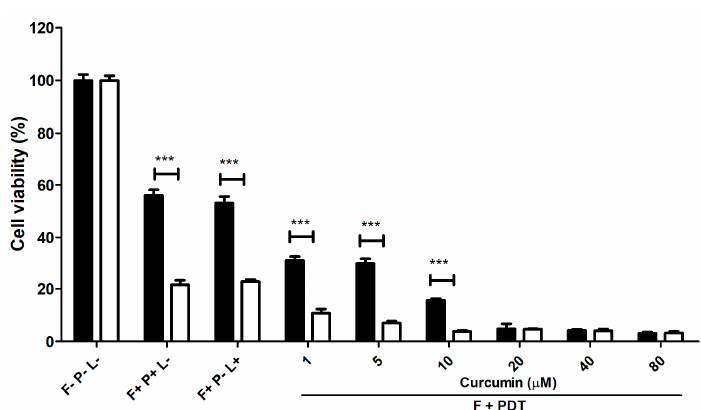
Figure 4. Viability of C. albicans in adherent culture after sequential treatment with fluconazole for 24 h (filled) or 48 h (open) and PDT utilizing curcumin. F, P, and L represent fluconazole, photosensitizer, and light, respectively. The symbol + indicates that the specific factor was used, and—indicates that the specific factor was not used. *** p < 0.001.